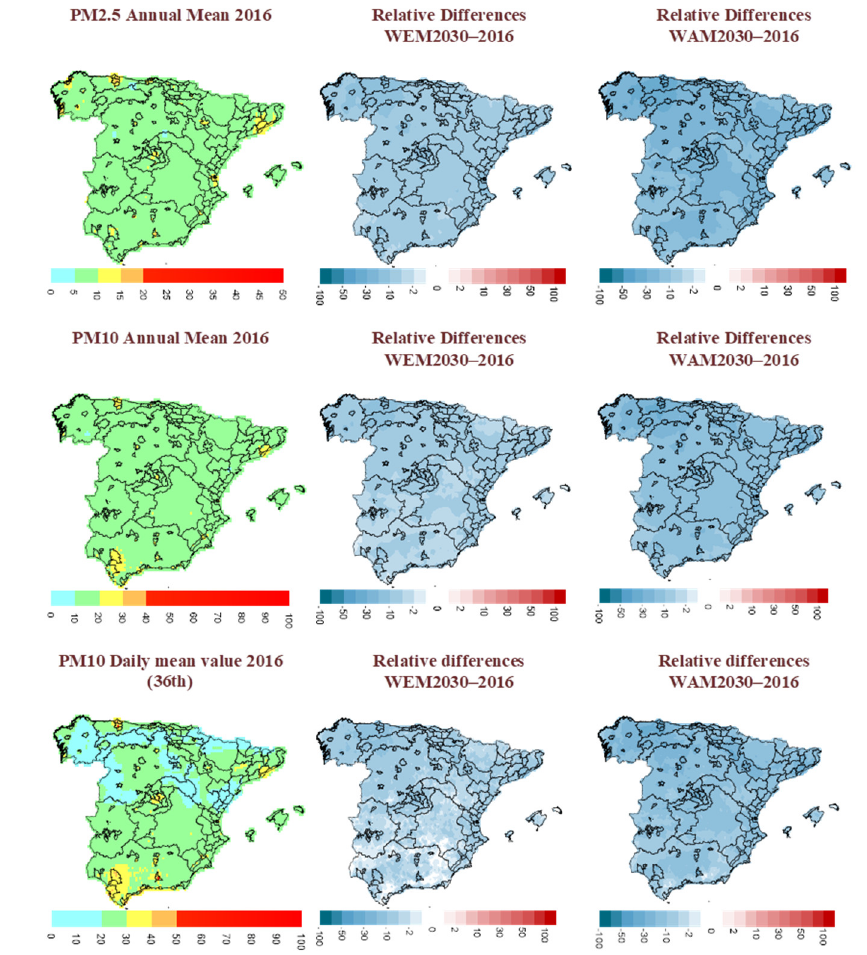
Figure 10. PM2.5 annual mean concentrations (top row, left, µg m −3 ). PM10 annual mean concen- trations (middle row, left) and PM10 daily mean concentrations (36th value, bottom row, left) for 2016 (µg m −3 ). Relative differences (%) with respect to 2016 are shown for the WEM2030 scenario (middle column) and WAM2030 (right column).